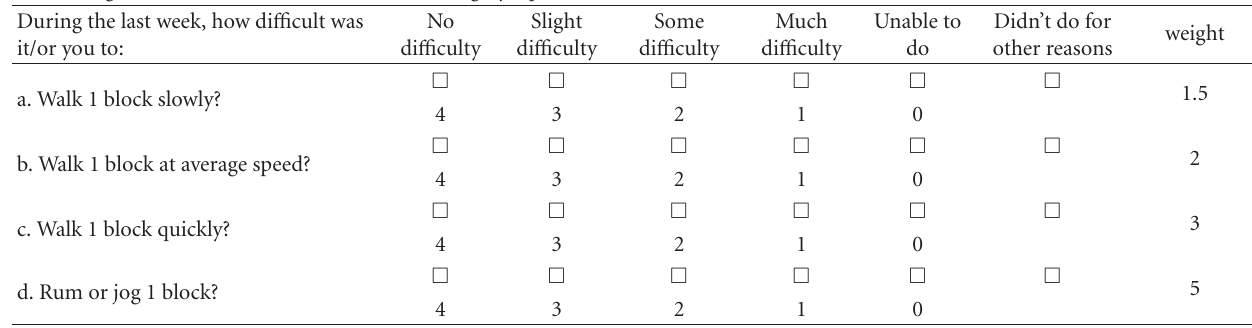
Table 7: Speed subscale of the WIQ.